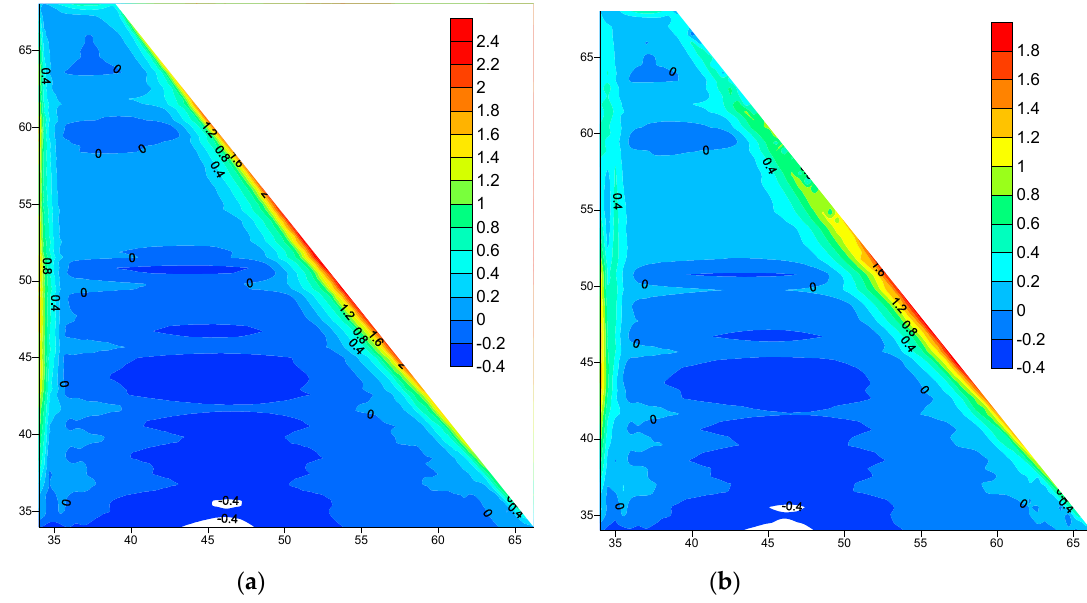
Figure 8. Maximum principle stress distributions with an empty reservoir during first winter December 2017(MPa): ( a ) Normal Placing Temperature, ( b ) Controlled Placing Temperature 20 °C .